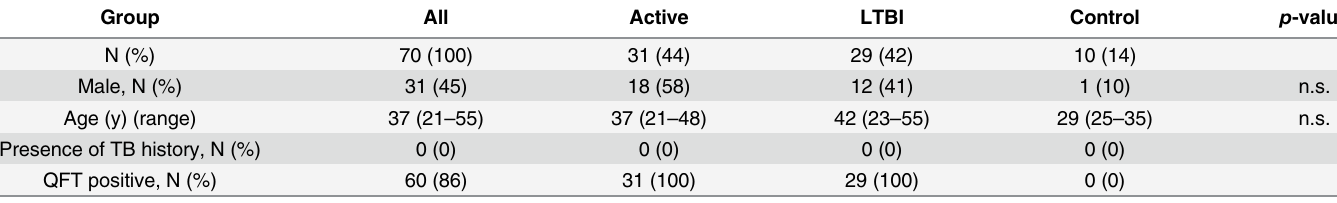
Table 1. Patient